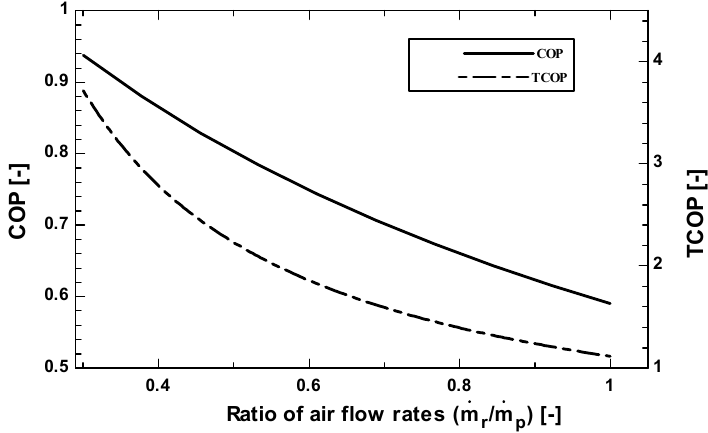
Figure 5. Effect of mass flow rate ratio on the system performance.